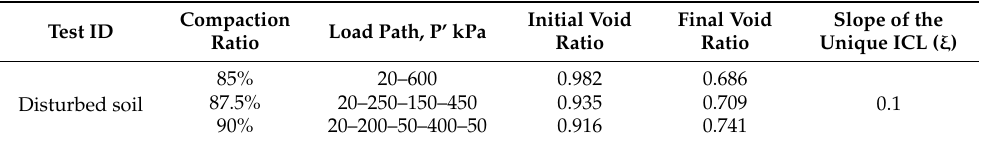
Table 2. Testing conditions of the isotropic compression path of the disturbed soil.